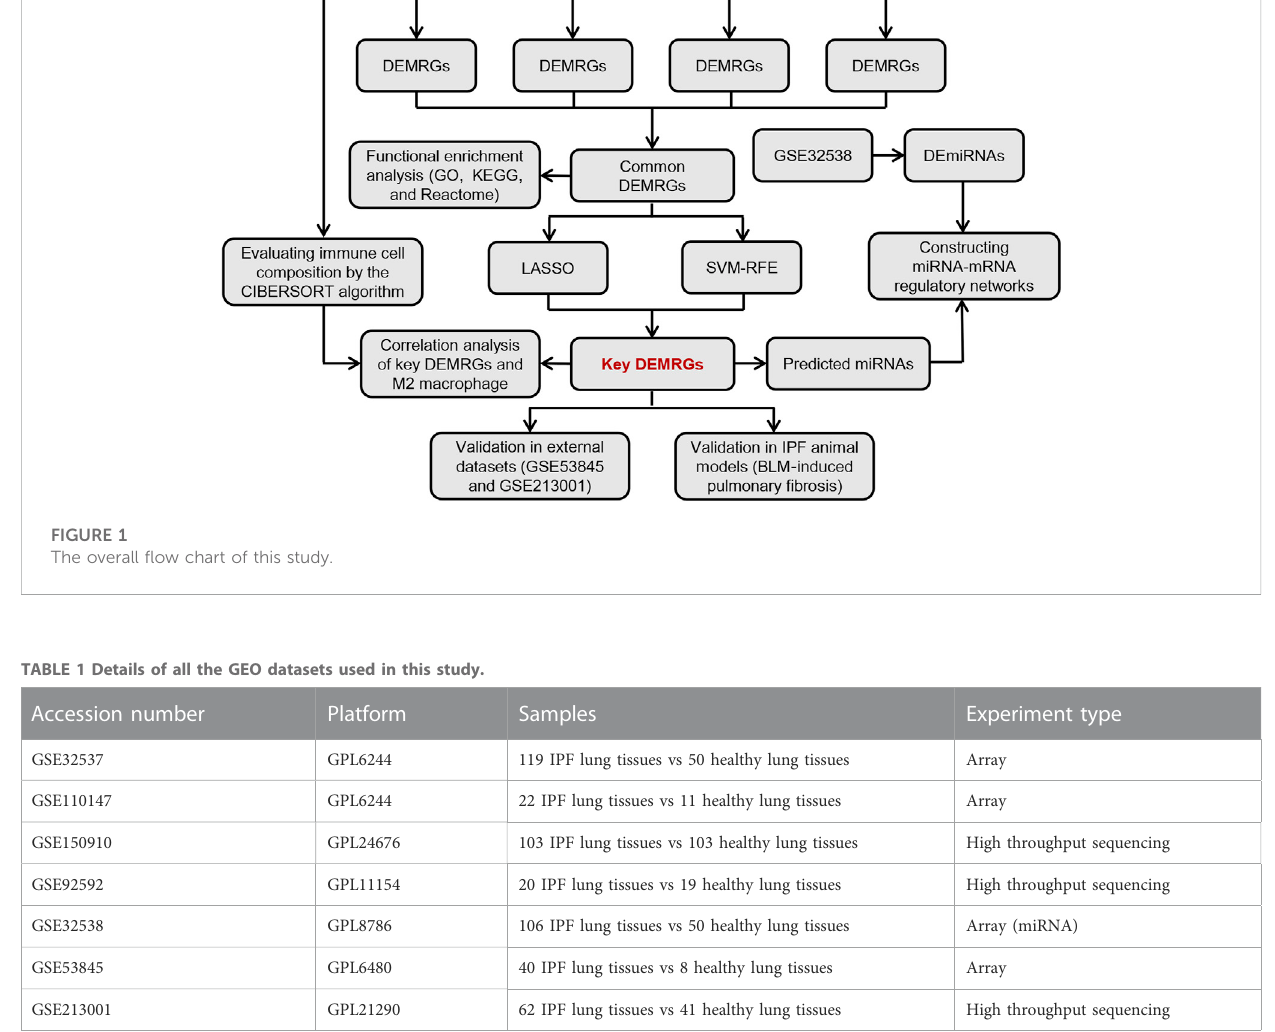
algorithm via the “ oligo ” R package for background correction